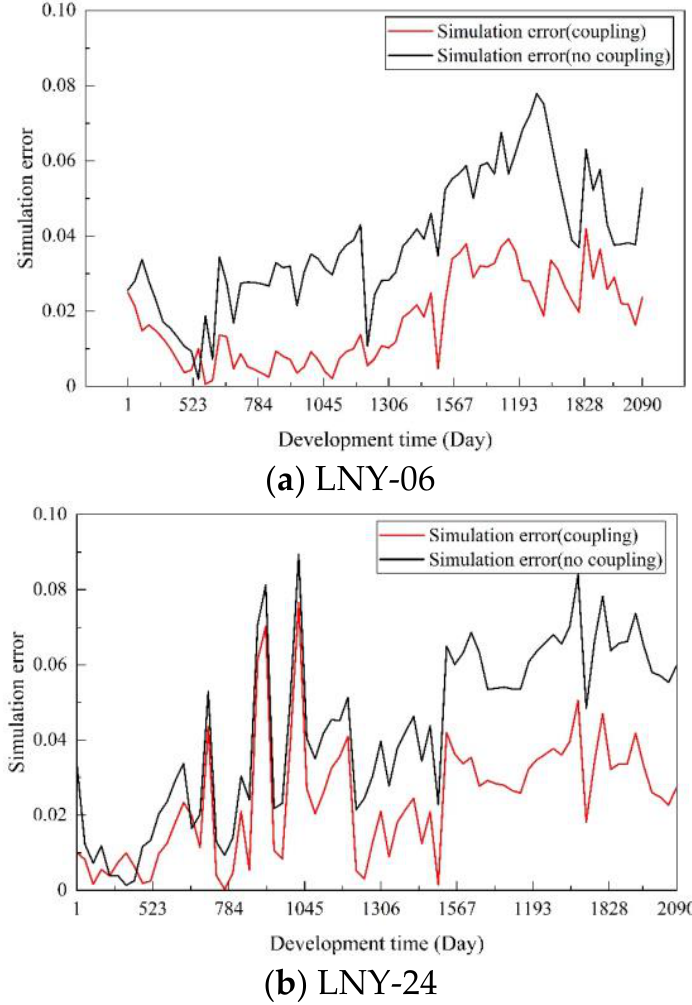
Figure 20. Comparison of bottom hole pressure fitting errors.